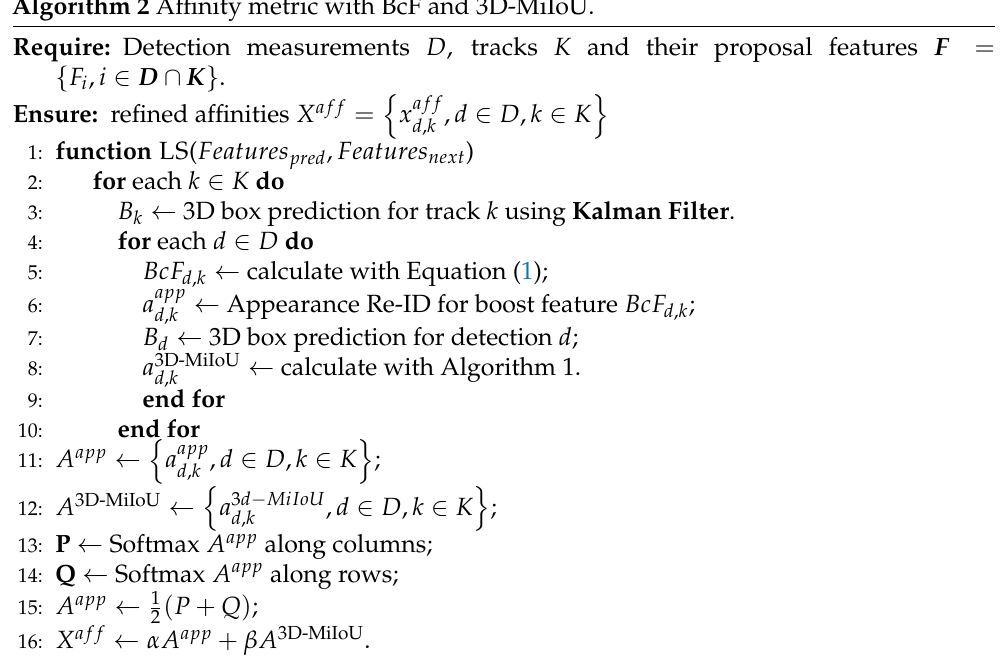
Algorithm 2 Affinity metric with BcF and